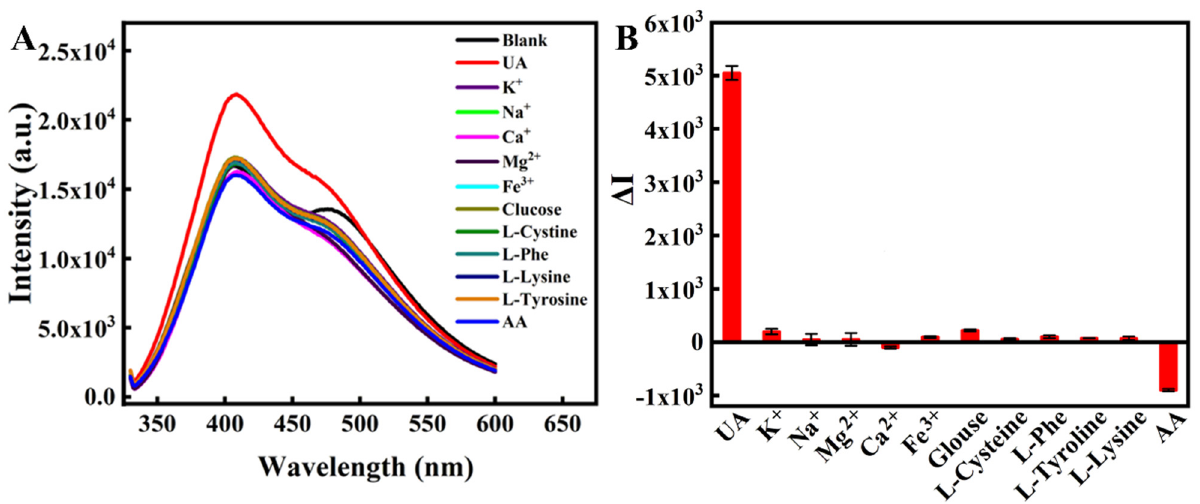
Figure 5. ( A ) Fluorescence emission spectra, and ( B ) corresponding fluorescence changes in the AgNPs/N-CQD system upon the addition of 200 µ mol/L of UA and 5000 µ mol/L of each interfering substance. The data are averages of five measurements and the error bars are standard deviations.